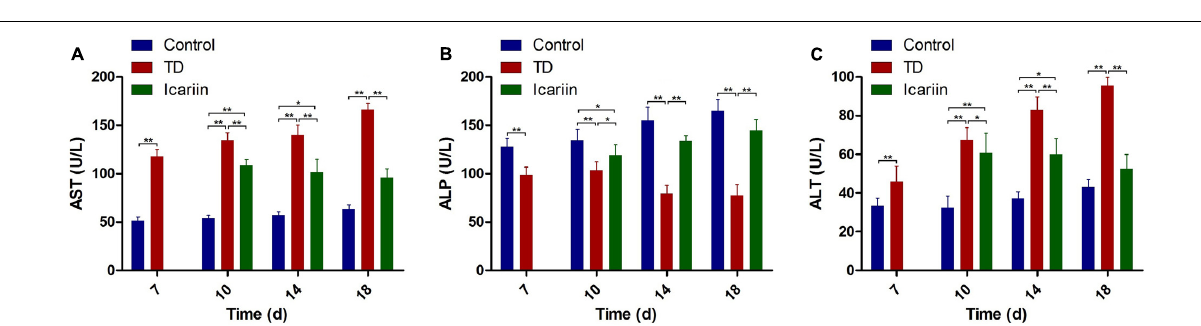
FIGURE 7 | Serum-biochemical analysis of control, TD, and icariin group on days 7, 10, 14, and 18. (A–C) Serum-biochemical analysis of AST, ALP, and ALT in control, TD and icariin groups on various days. The data are presented in mean ± SD. ∗ P < 0.05, ∗∗ P <